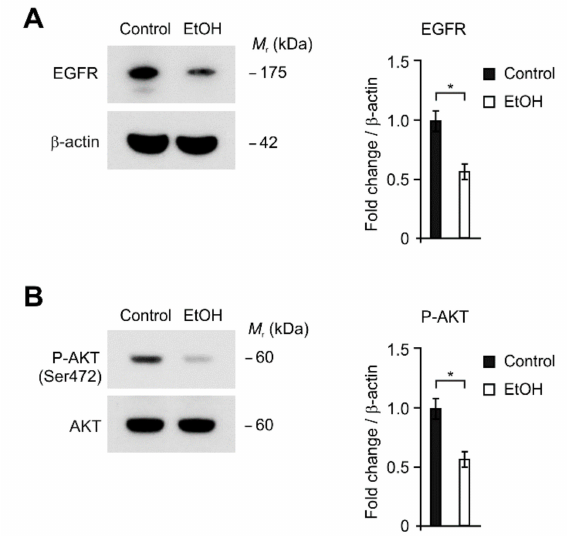
Figure 4. The levels of EGFR and AKT phosphorylation were reduced by alcohol exposure in HEI-OC1 cells. ( A ) Representative immunoblot analysis for HK1 ( left ) and quantification for HK1 protein levels ( right ) from HEI-OC1 cells treated with ethanol (EtOH, 0.05%) or vehicle (Control) for 4 h. For immunoblots, β -actin was used as loading control. Data are representative of three independent experiments. ( B ) Representative immunoblot analysis for AKT phosphorylation ( left ) and quantification for AKT phosphorylation levels ( right ) from HEI-OC1 cells treated with ethanol (EtOH, 0.05%) or vehicle (Control) for 4 h. For immunoblots, total AKT was used as loading control. Data are representative of three independent experiments. Data are mean ± SEM. * p < 0.05 using the two-tailed Student’s t